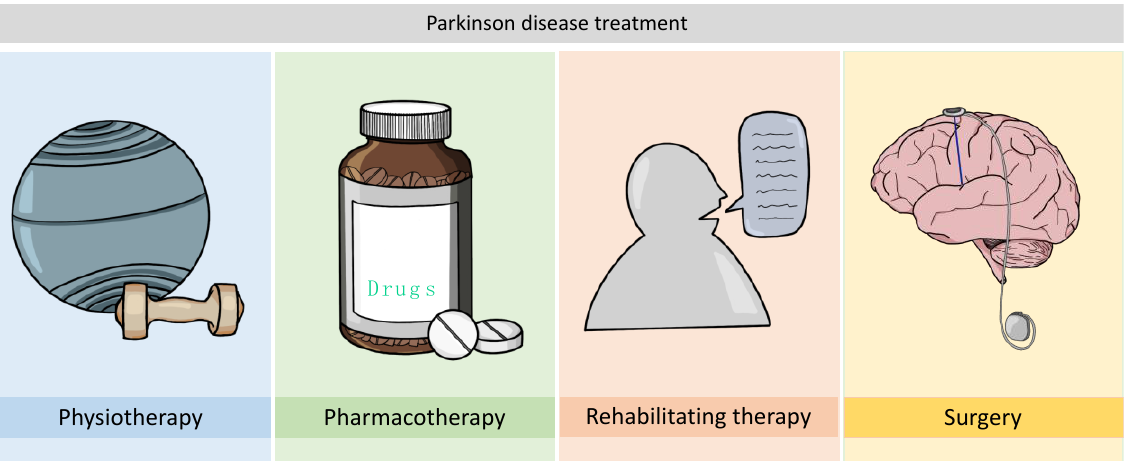
Figure 2. The current Parkinson’s disease treatment introduced to recently diagnosed patients.